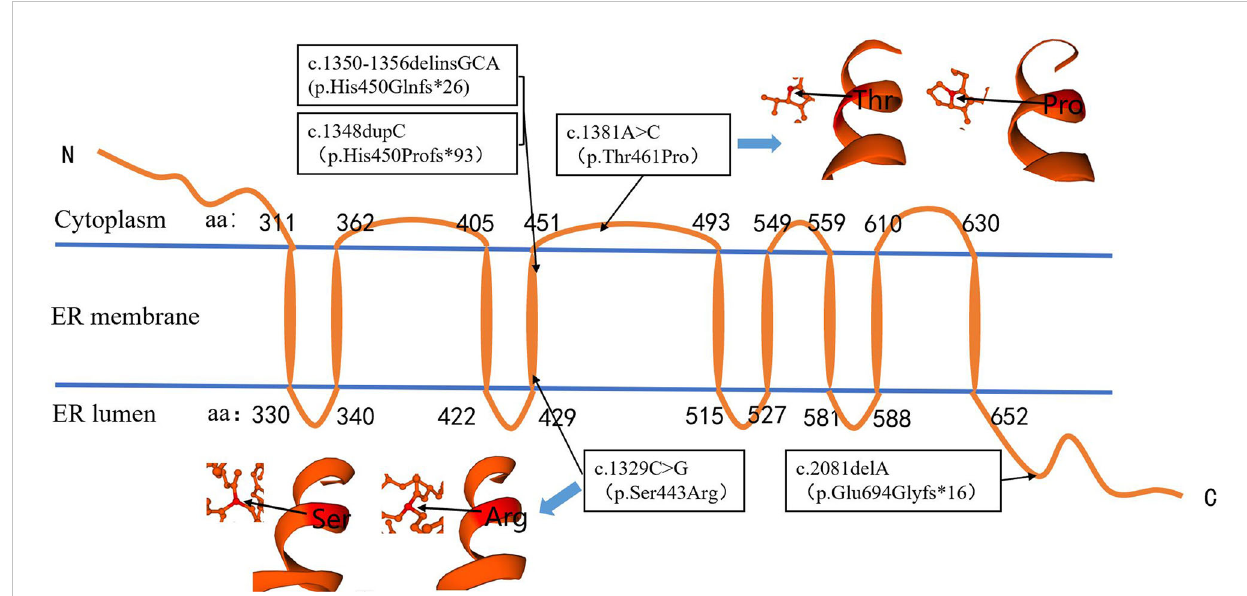
FIGURE 3 Localization of variation site (P/LP) in protein region and prediction of protein structure in amino acid residue region. The amino acids encoded by c.1348, c.1329, and c.1350 – 1356 were located in the fourth transmembrane region of WFS1 protein. The amino acids encoded by c.1381 were located in the non-transmembrane region of the cytoplasm. The amino acid encoded by c. 2081 was located in the COOH terminal domain of the endoplasmic reticulum. The c.1381A>C and c.1329C>G variations did not affect the formation of the a -spiral